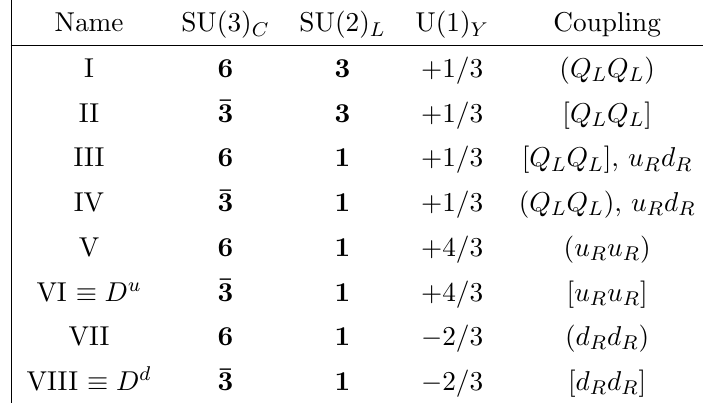
Table 1 . Scalar diquarks classi(cid:12)ed by their charges under the SM gauge group. In the ‘Coupling’ column, parentheses indicate a symmetric coupling and square brackets indicate an antisymmetric coupling with respect to (cid:13)avour indices